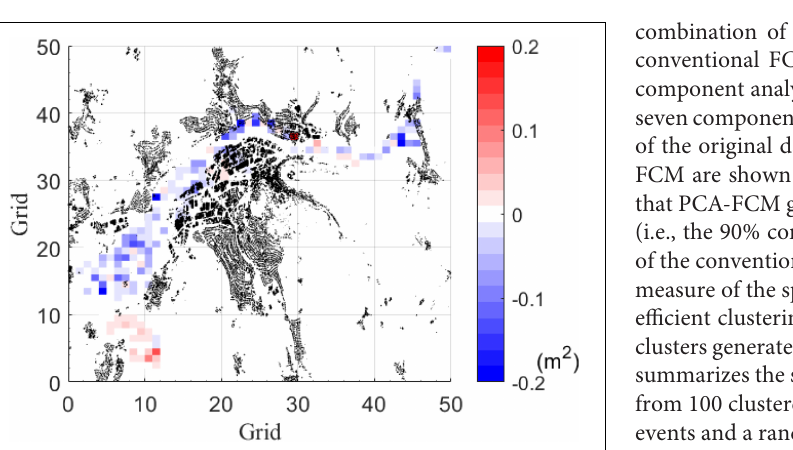
FIGURE 4 | Difference of average MSE by the two training algorithms in the training dataset (Event #1 to Event #120). Each grid is an ANN. Black elements are houses. Negative values indicate that RP performs better than CGF (i.e., smaller MSE). In the plot, 149 grids have positive values and 335 grids have negative values.